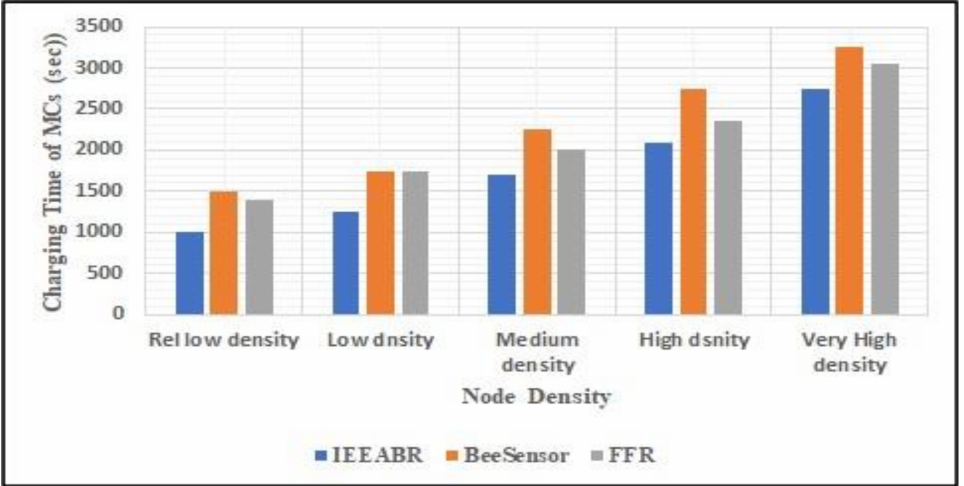
Figure 18. Charging time of MCs during a